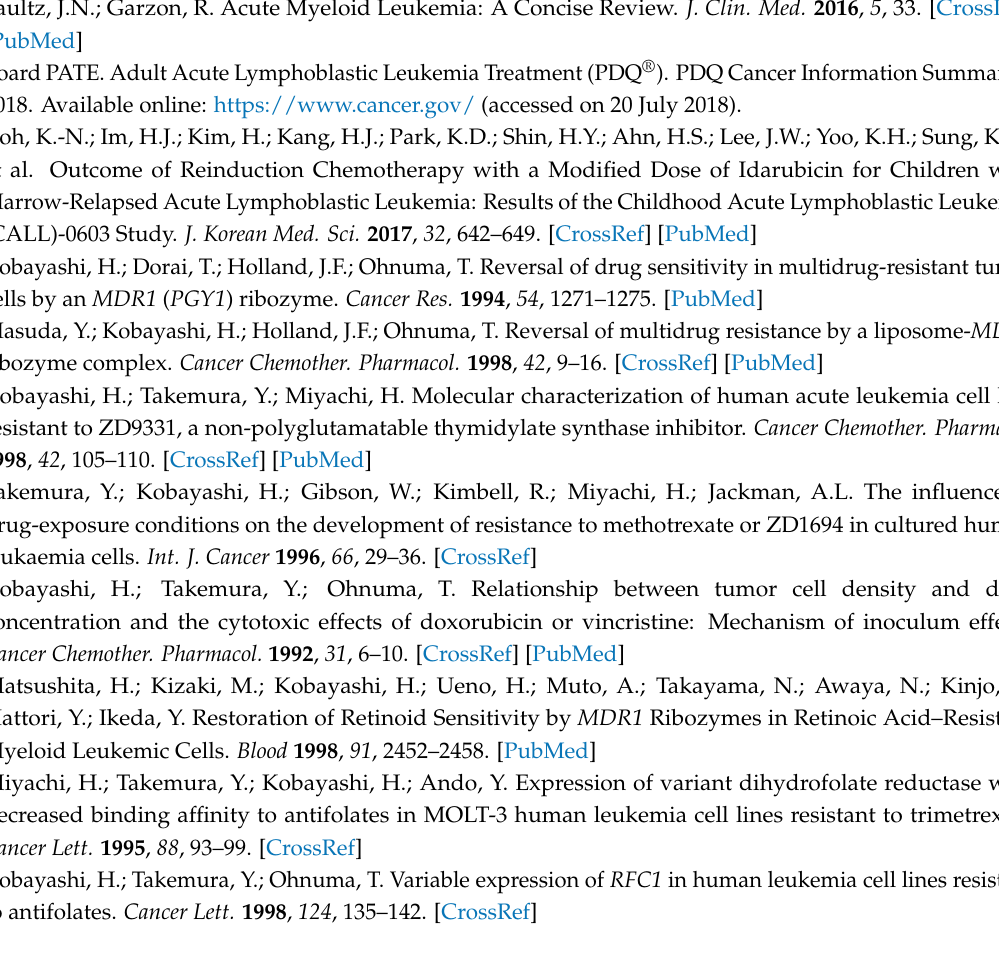
Table S1: Levels of IDR resistance in MOLT-3 and MOLT-3/IDR cells. Table S2: Genes specific to MOLT-3/IDR cells (8839 genes). Table S3: Genes with amino acid mutations specific to MOLT-3/IDR cells (1162 genes). Table S4: Raw data for IDR Permeability in MOLT-3 and MOLT-3/IDR cells using